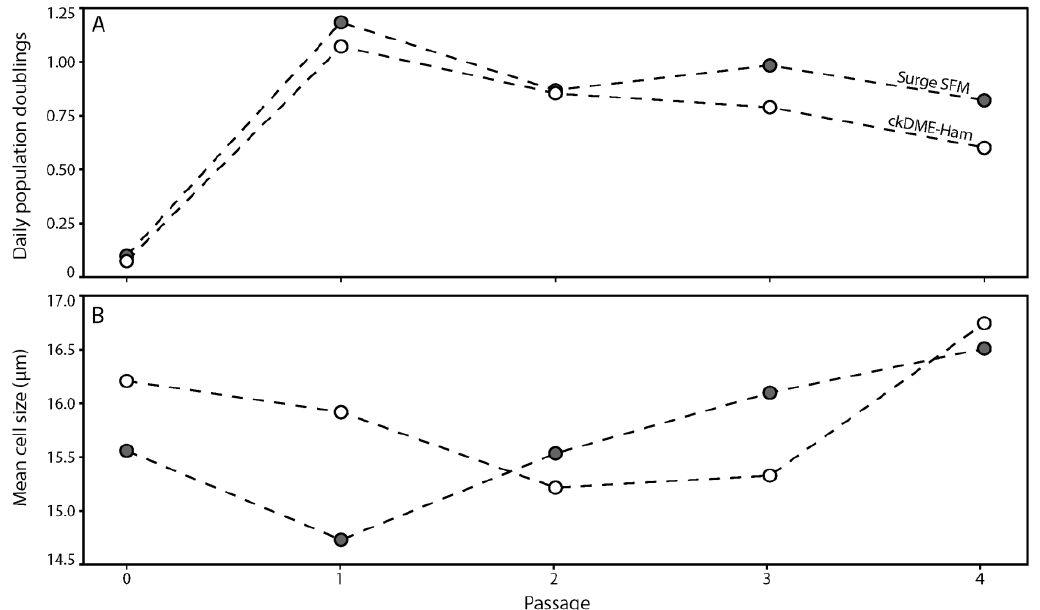
Figure 1. Line-connected dot plots of ( A ) the number of daily population doublings and ( B ) the mean cell size (μm) of k2 primary keratinocytes over five passages. Dot fill colors indicate the medium used to isolate and culture keratinocytes (gray: Surge SFM and white: ckDME-Ham). Dots are means of triplicates. Technical variability did not exceed 15%.